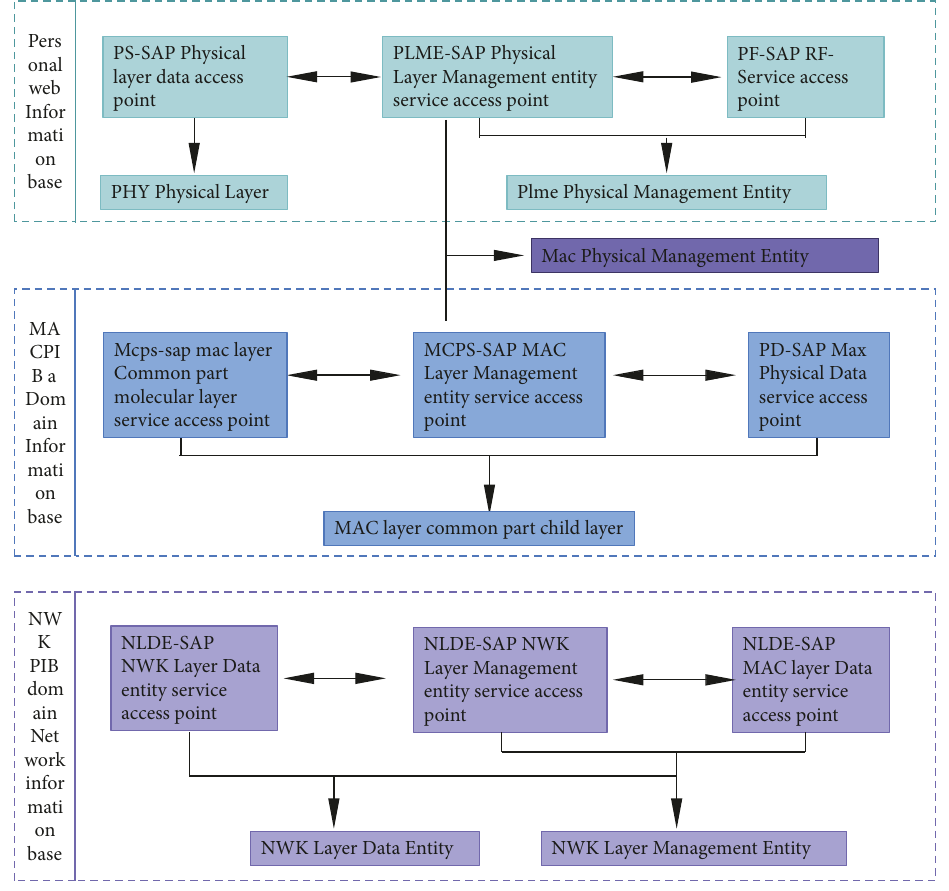
Figure 5: Schematic diagram of ZigBee protocol